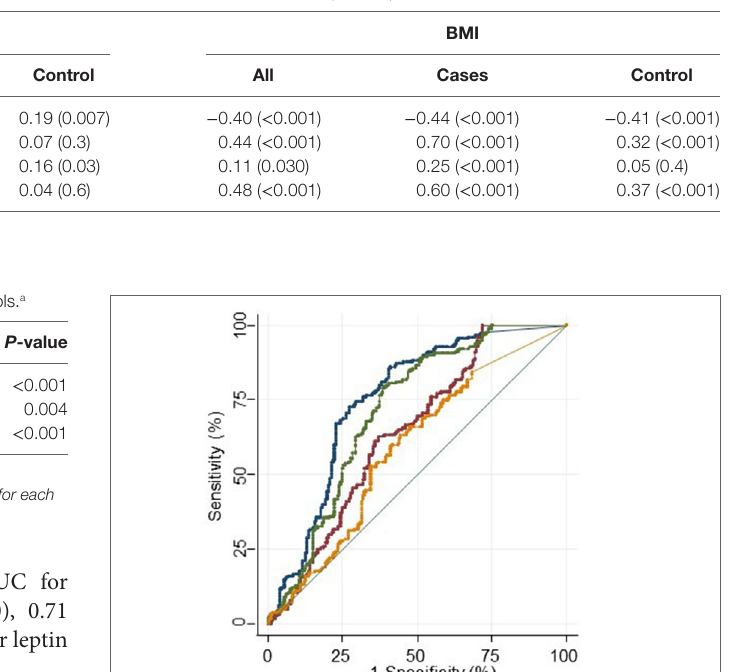
TaBle 3 | Correlation between age, Body Mass Index (BMI), and serum biomarkers, values are Pearson correlation ( P